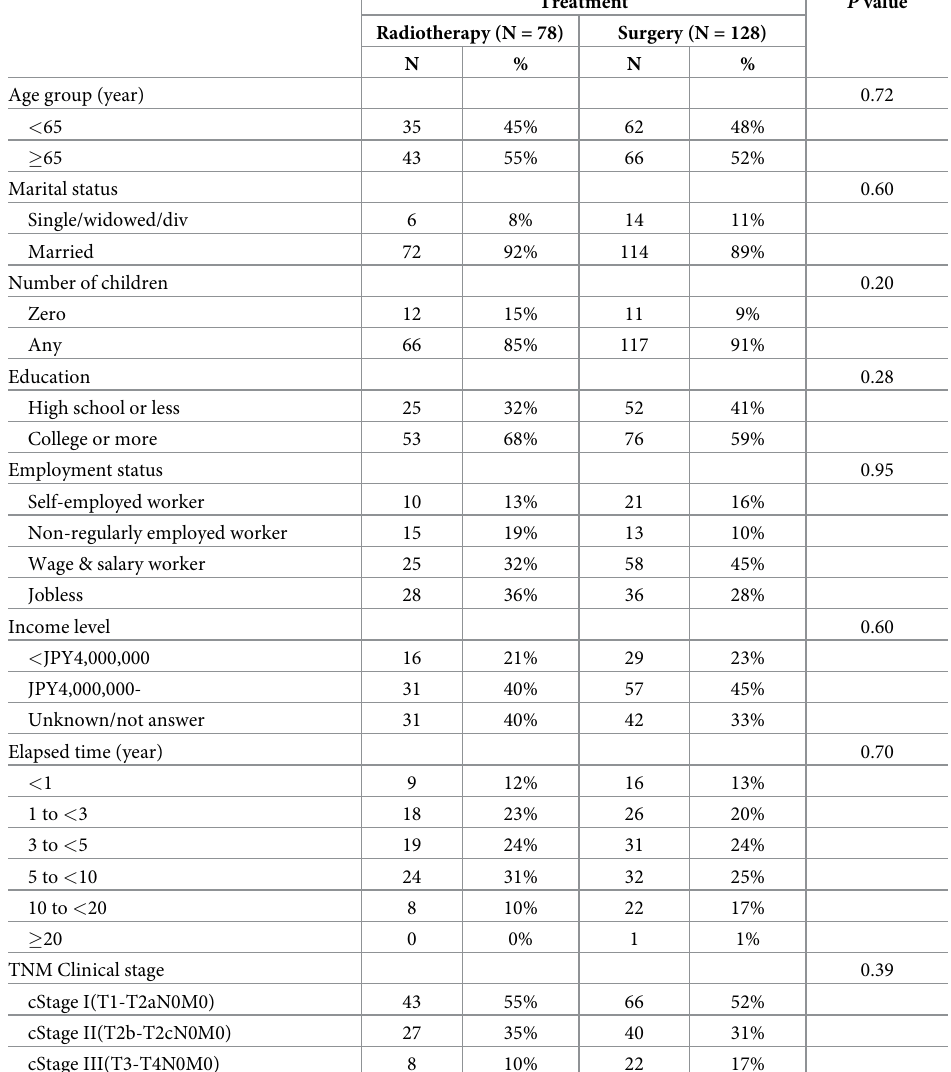
Table 1. Baseline characteristics between radiotherapy group and surgery group at their prostate cancer